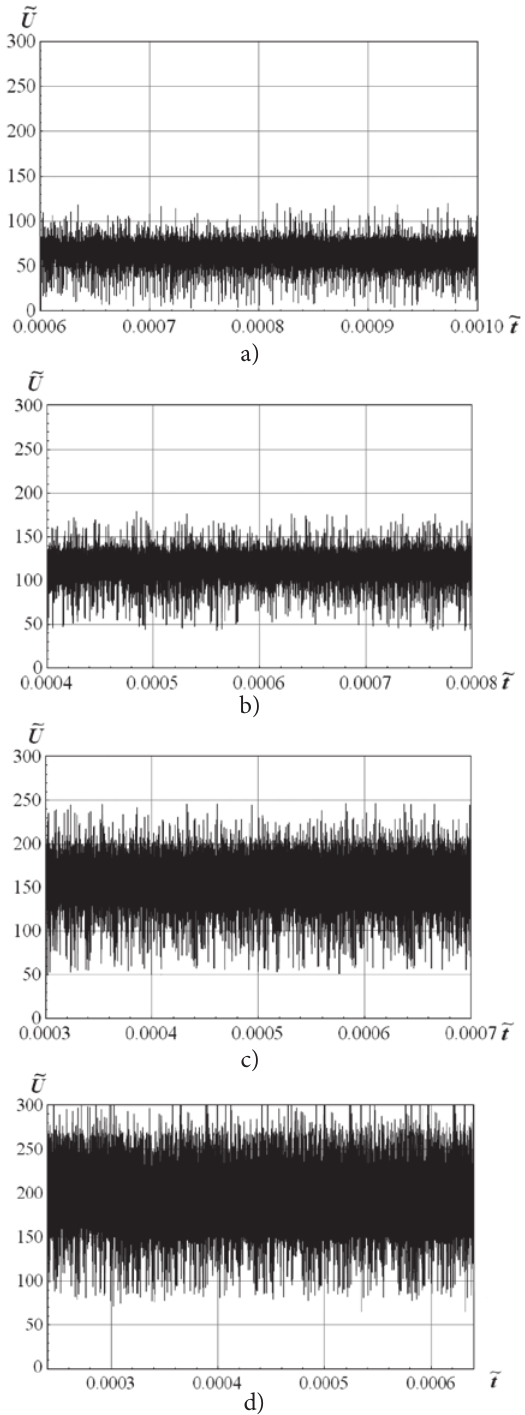
Fig. 3. A diagram of AE resultant signal amplitude variation over time, in relative units during friction of CM surface layers, υ  = 1000000; r  = according to (2). Simulation parameters: 0 σ  = 0.101941909. Values α  , 10000; g  = 0.1; t  and t D  0 0 j are: a) α  = 200, t  = 0.0012, t D  = 1.1×10 –6 ; b) α  =300, 0 j t  = 0.0006, t D  = 8.0×10 –7 ; c) α  = 400, t  = 0.0004, t D  = 0 j 0 j 7.0×10 –7 ; d) α  = 500, t  = 0.00024, t D  = 6.0×10 –7 . The initial 0 j value δ  varies randomly in the range from 0 to 5×10 –7